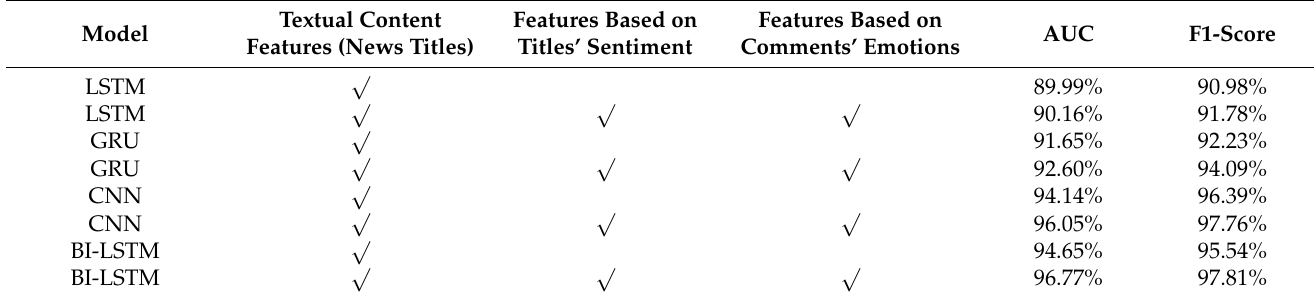
Table 5. The results of the proposed models according to the features used, (A checkmark indicates that this feature is selected).